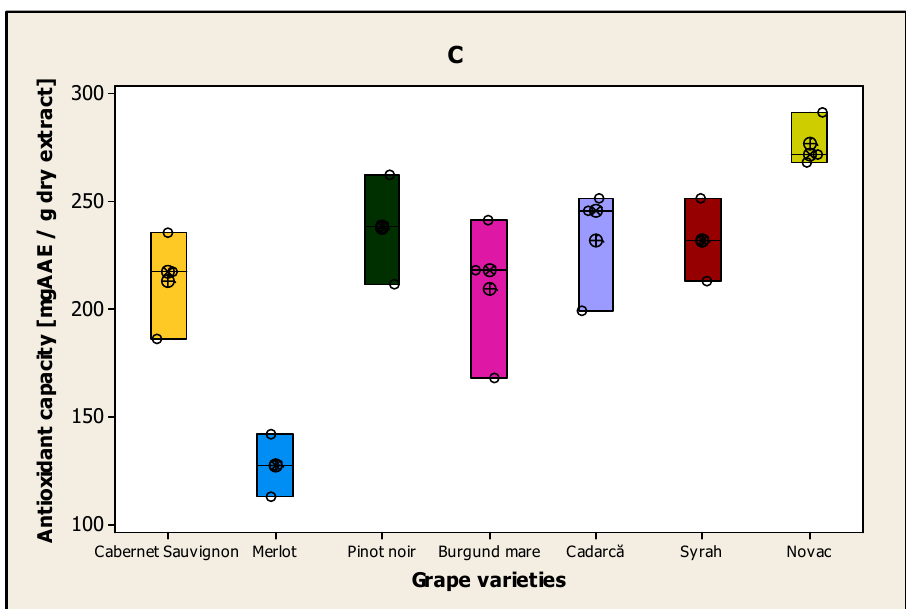
Figure 2. ( A ) Antioxidant capacity determined from the seeds of the seven grape varieties on the first day; ( B ) antioxidant capacity determined from the seeds of the seven grape varieties on the 14th day; ( C ) antioxidant capacity determined from the seeds of the seven grape varieties on the 30th day.